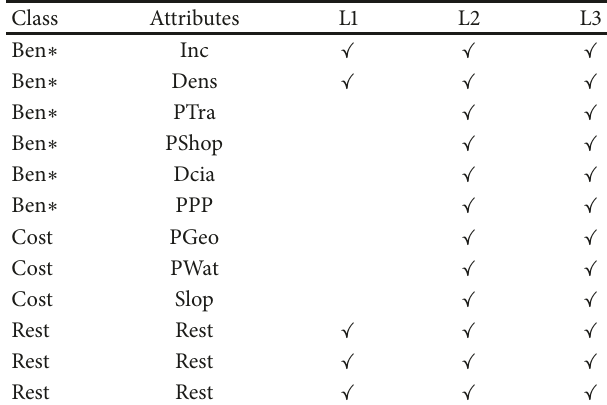
Table 4: Attributesconsidered in the survey( ✓ presence, ∗